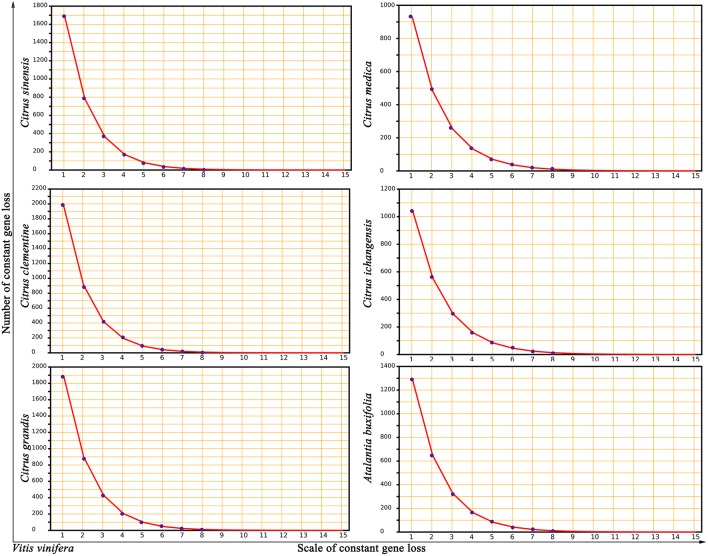
Near geometric distribution of continually lost or translocated genes between grape and Rutaceae plants. Vitis vinifera was compared to 5 citrus (Citrus sinensis, Citrus clementine, Citrus grandis, Citrus medica, and Citrus ichangensis) and one relative, Atalantia buxifolia. The x-axis represents numbers of continually lost or translocated genes in the inferred homologous regions. The y-axis represents the number of removed genes.